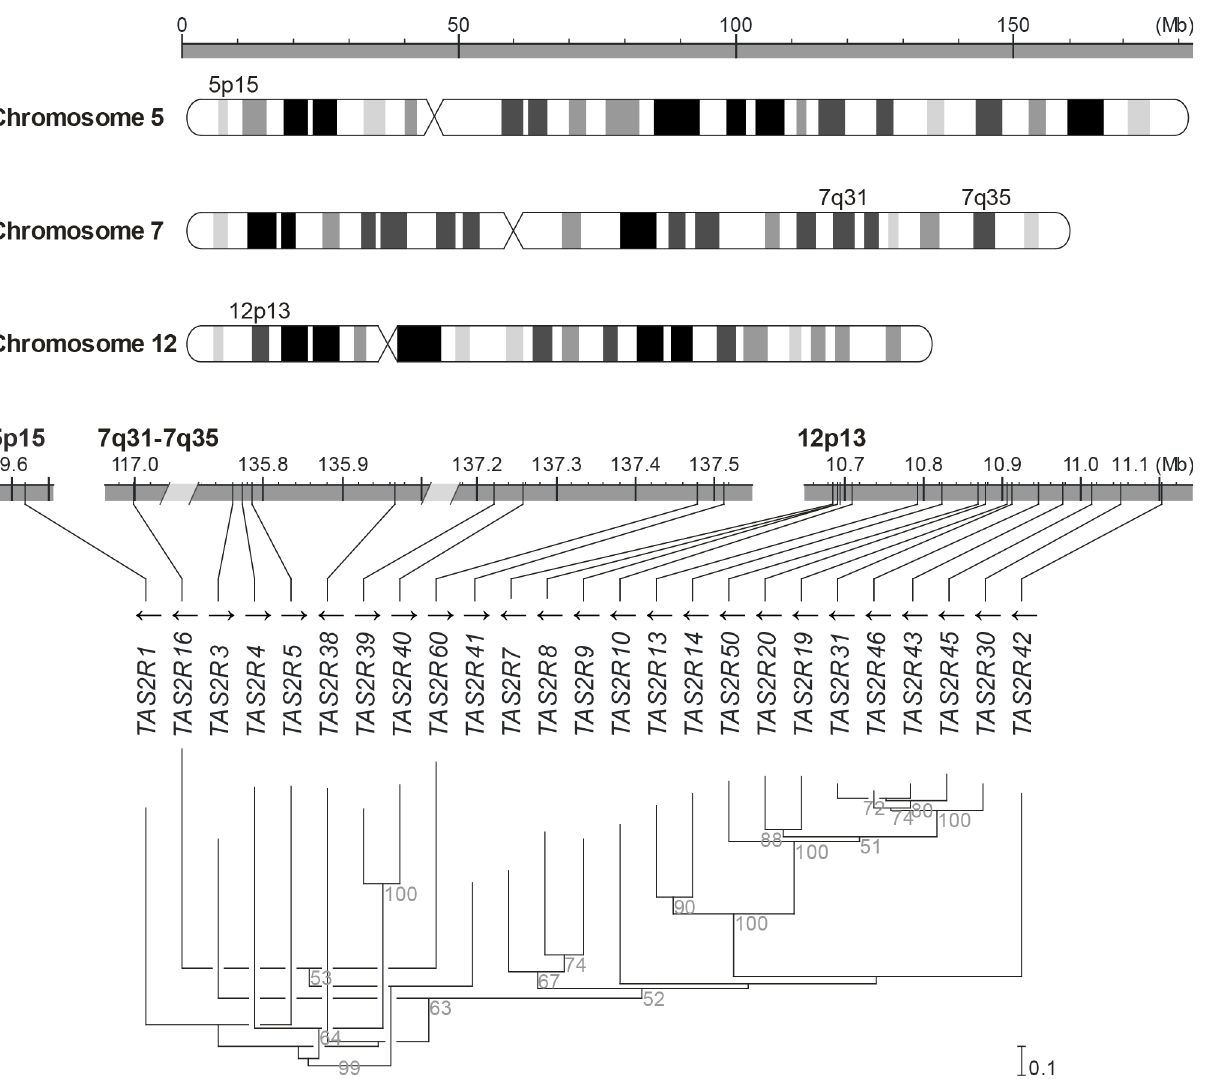
Fig 1. Genomic organisation and phylogenetic tree of the TAS2R gene family. TAS2R genes are distributed among the cytogenetic locations 5p15, 7q31-7q35 and 12p13 on chromosome 5, 7 and 12, as shown on the ideogram of the G-banding pattern at the 850 band resolution [35]. One gene, TAS2R1 , is located at 5p15. Nine are located on chromosome 7 in a ~20.5 Mb region spanning the cytogenetic location 7q31-7q35, which contains TAS2R16 and, separated by a ~18.8 Mb distance on the same chromosome, eight other TAS2R genes: TAS2R3 , -4 , -5 , -38 , -39 , -40 , -60 , and -41 . Fifteen TAS2R genes are located on chromosome 12 in a ~400 kb region at 12p13: TAS2R42 , -30 , -45 , -43 , -46 , -31 , -19 , -20 , -50 , -14 , -13 , -10 , -9 , -8 , and -7 . Evolutionary analyses indicated that genomic location is associated with phylogenetic affiliation, as previously published